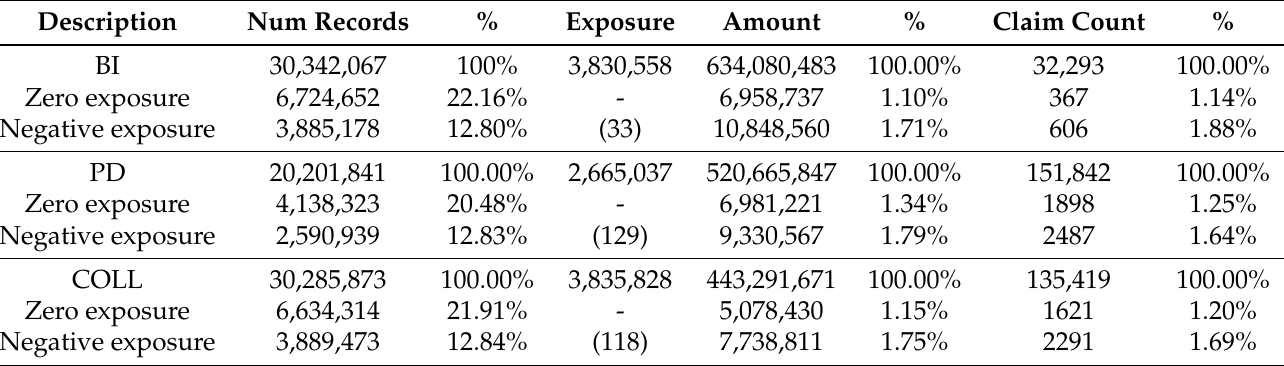
Table 1. General description of the three datasets.